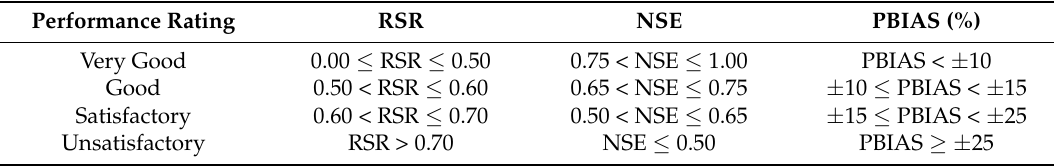
Table 2. Performance ratings for recommended statistics for monthly flow